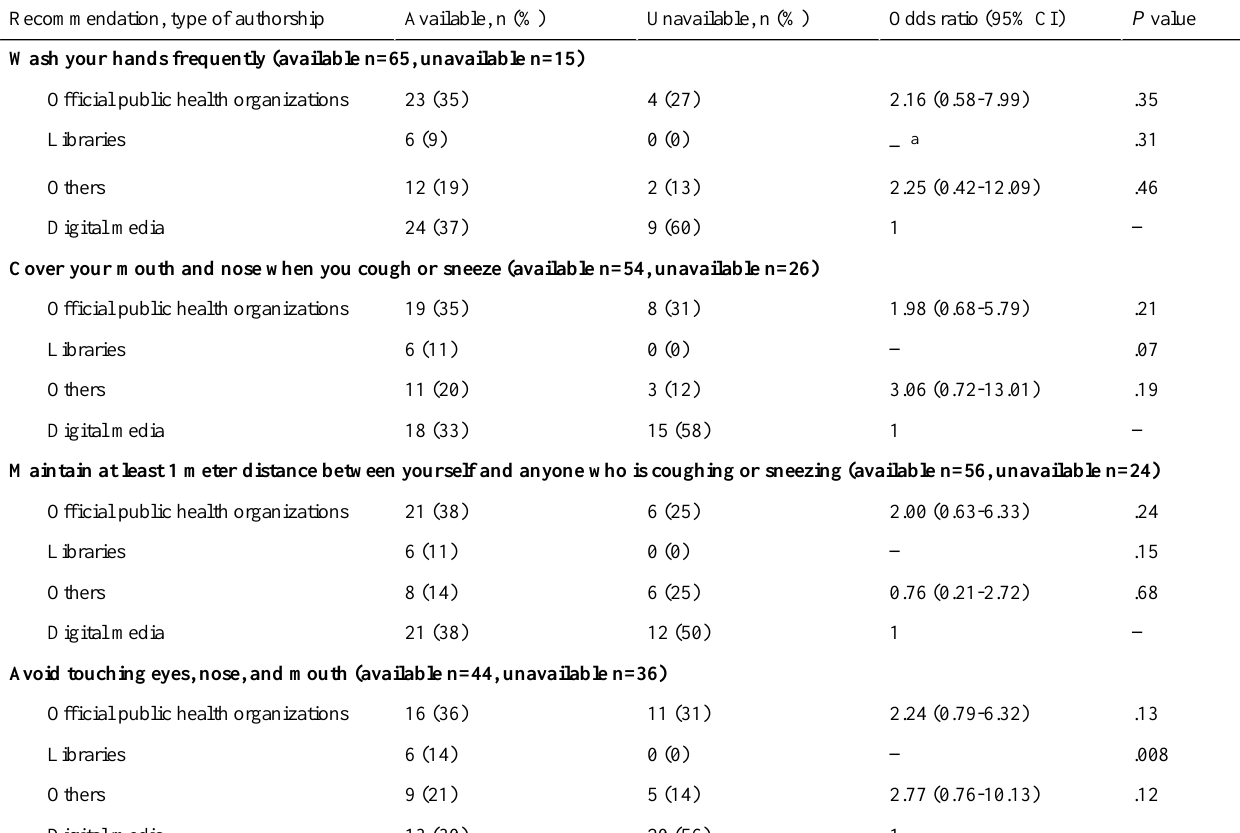
Table 2. Recommendations to avoid COVID-19 according to the World Health Organization and information about them available on the internet according to their